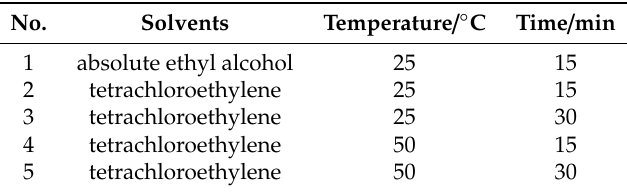
Table 1. Parameters of the specimen